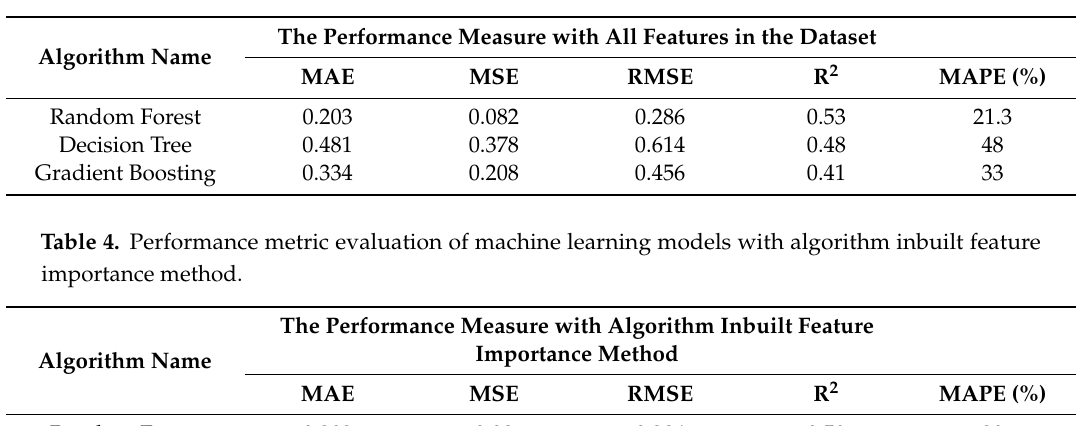
Table 3. Performance metric evaluation of machine learning models with all the dataset features.